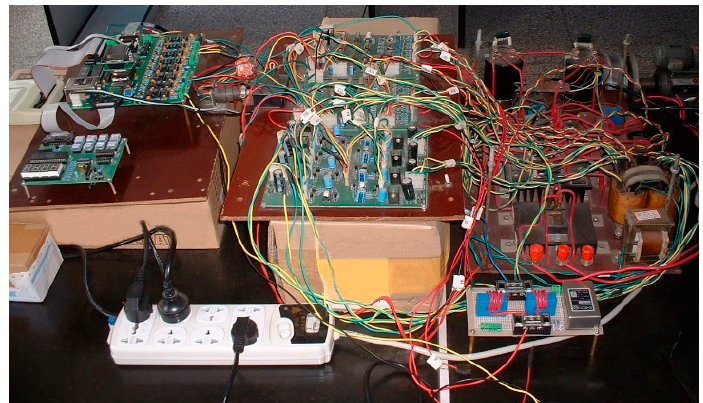
Figure 14. Measuring stand for determination of SRM-drive system properties.